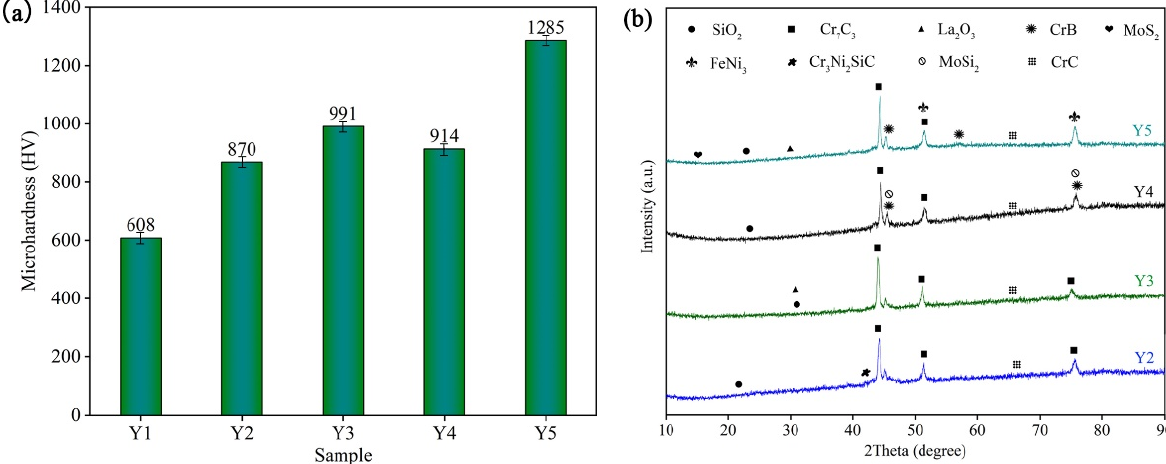
Figure 2. Micro-hardness ( a ) and XRD pattern ( b ) of the composite coating.